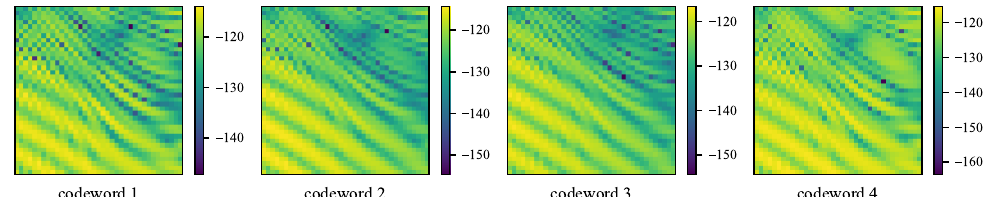
Figure 8. Shifted RSSI measurements (dB) using four different codewords for the same area. Each pixel denotes an RSSI